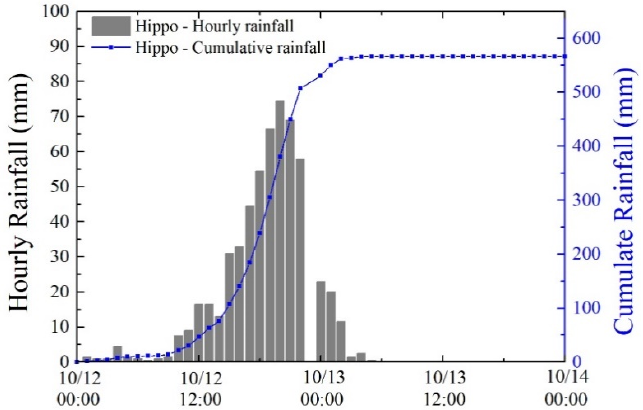
Figure 4. Rainfall data at Hippo Station in the Abukuma River.